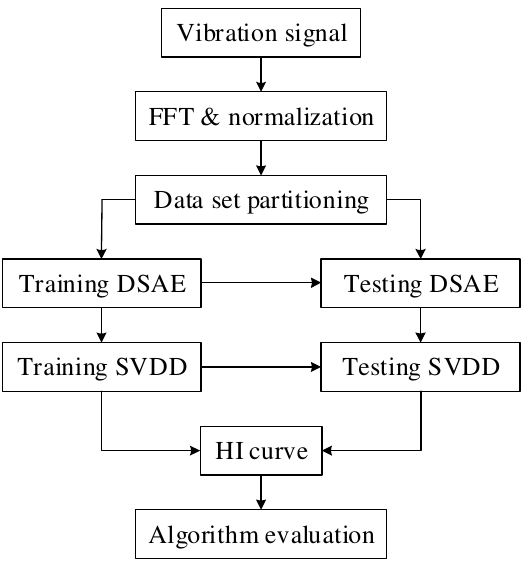
Figure 13. HI curve drawing and algorithm evaluation.